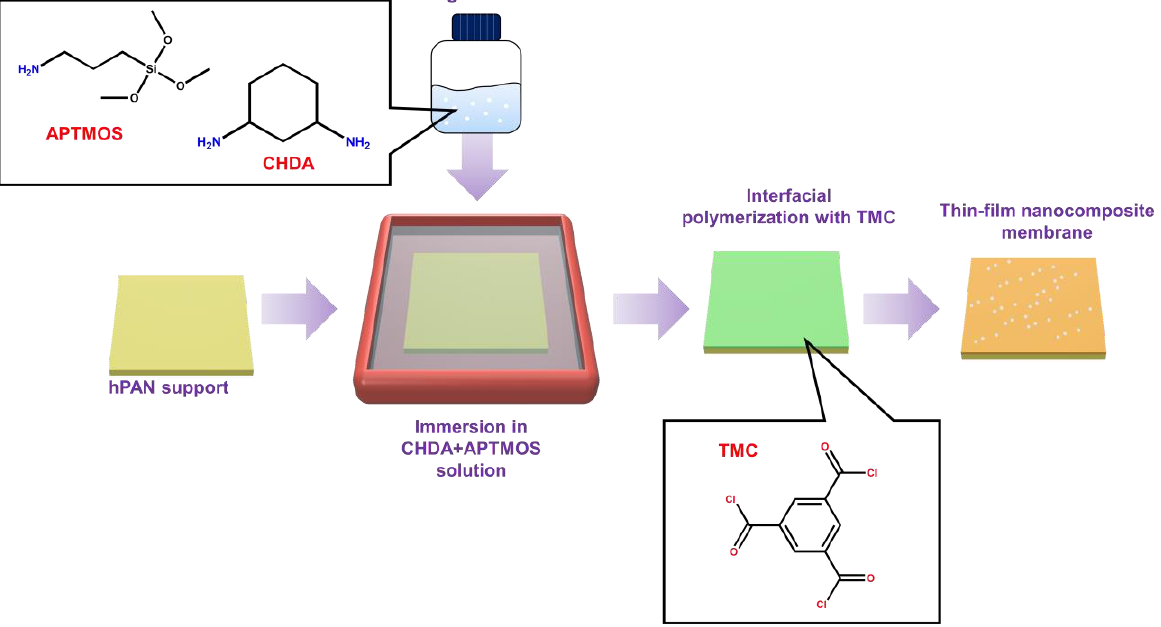
Figure 1. Schematic diagram of preparing a thin-film nanocomposite membrane with embedded silica nanoparticles generated in situ from the reaction between APTMOS and CHDA.